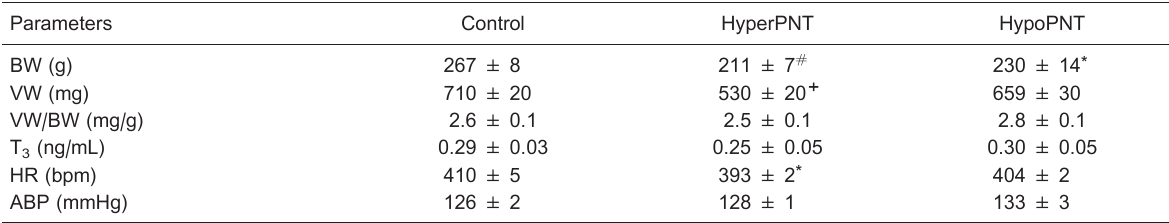
Data are reported as means±SE of 3 independent experiments for 6-8 animals/group. BW: body weight; VW: ventricular weight; HR: heart rate; ABP: arterial blood pressure; T 3 : triiodothyronine; PTU: propylthiouracil. *P , 0.05, # P , 0.01, + P , 0.001 vs control group